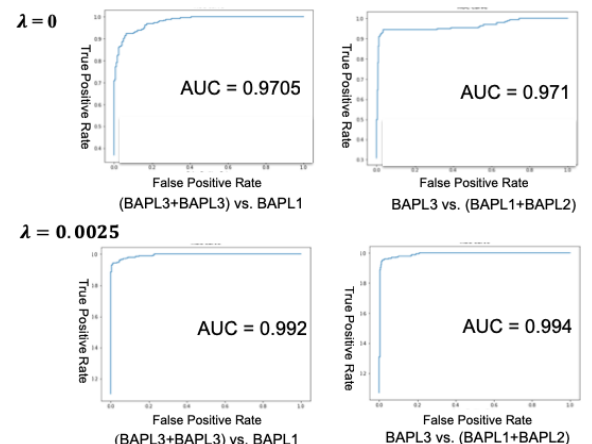
Figure 6. ROC curves and AUCs of the conventional loss ( top ) and the proposed joint loss ( bottom ).